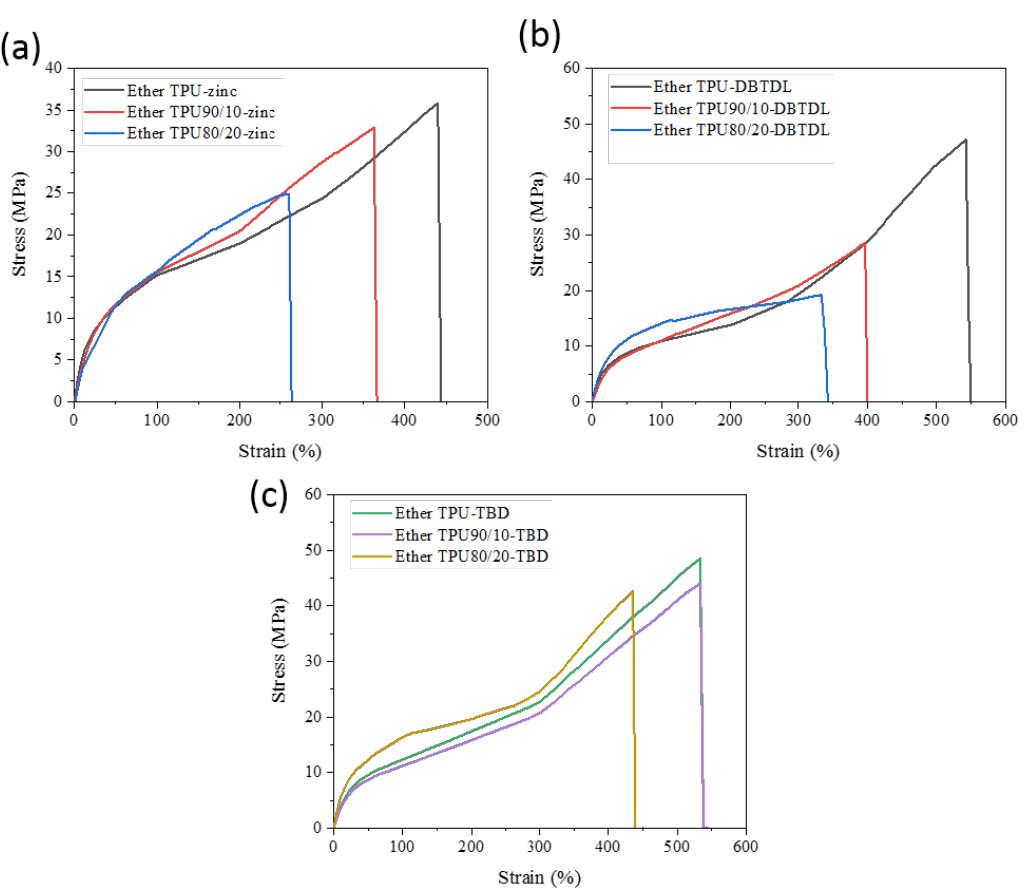
Figure 5. Stress-strain curves for the ether TPU / phenoxy resin blends: ( a ) ether TPU / phenoxy with zinc acetate as the catalyst; ( b ) ether TPU / phenoxy with DBTDL as the catalyst; ( c ) ether TPU / phenoxy with TBD as the catalyst.